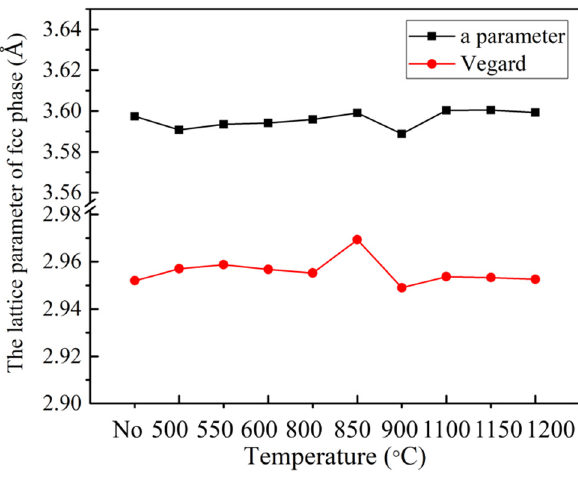
Figure 5: The lattice parameters of the FCC matrix for as - sintered and as - annealed Co 28.5 Cr 21.5 Fe 20 Ni 26 Mo 4